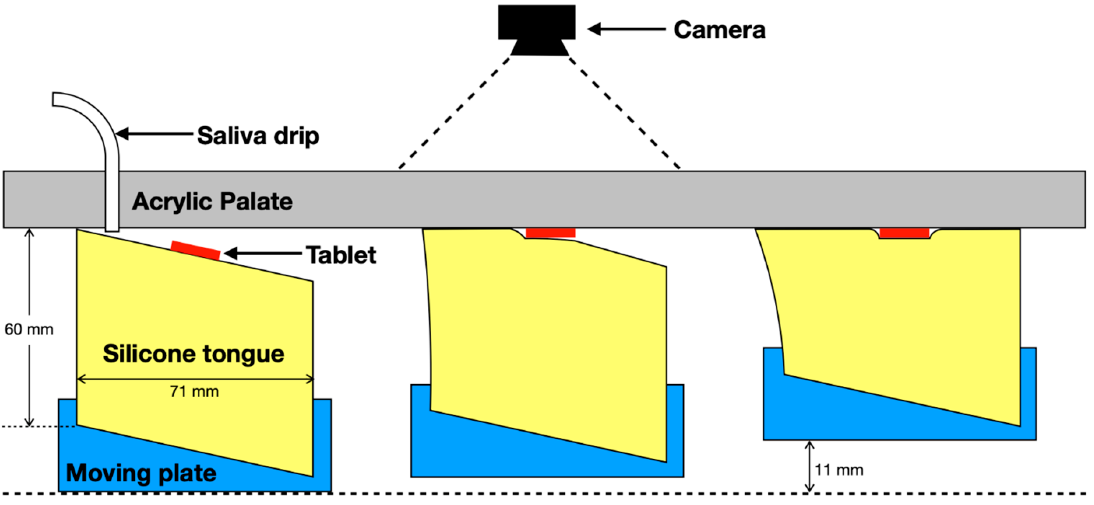
Figure 1. Schematic of oral cavity model (OCM) (side view/sagittal plane). On the left is the initial position and on the right is full compression.